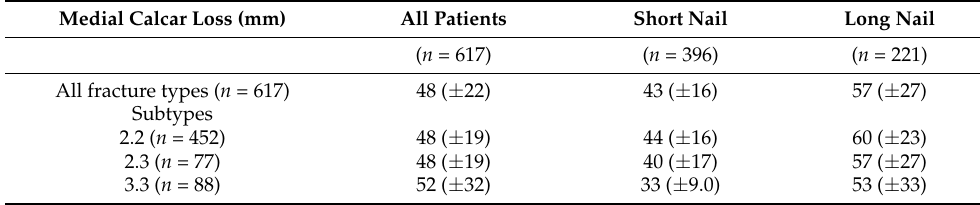
Table 1. Medial calcar loss and nail length.